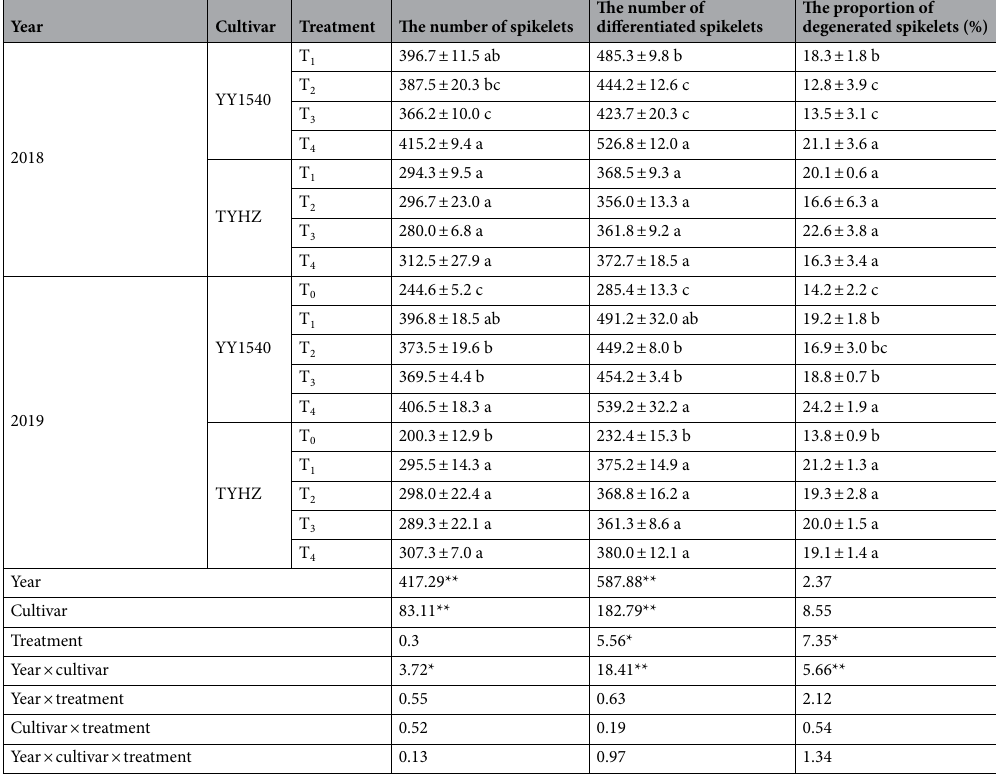
Table 2. Effect of nitrogen fertilization mode on spikelet differentiation and degeneration of primary stems of indica – japonica hybrid rice (‘Yongyou1540’, YY1540) and indica hybrid rice (‘Tianyouhuazhan’, TYHZ). Values followed by different lower-case letters within the same column are significantly different among treatments. * p < 0.05; ** p <